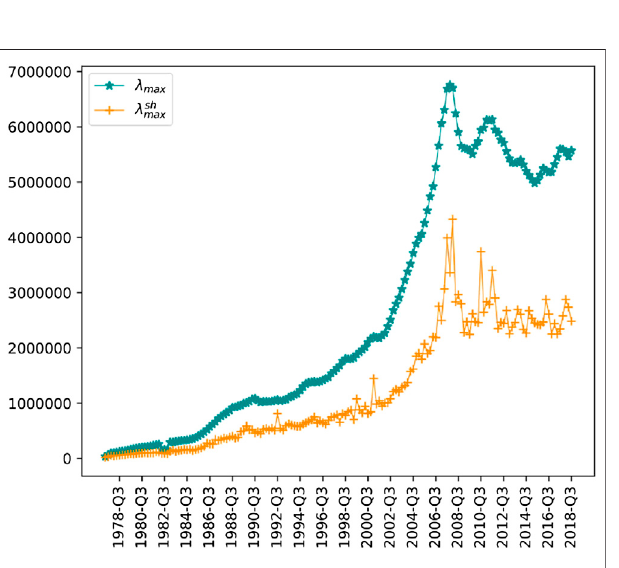
FIGURE 3 | The evolution of the largest eigenvalue, λ max , of the global banking network and its shuf fl ed, λ sh max , are depicted.